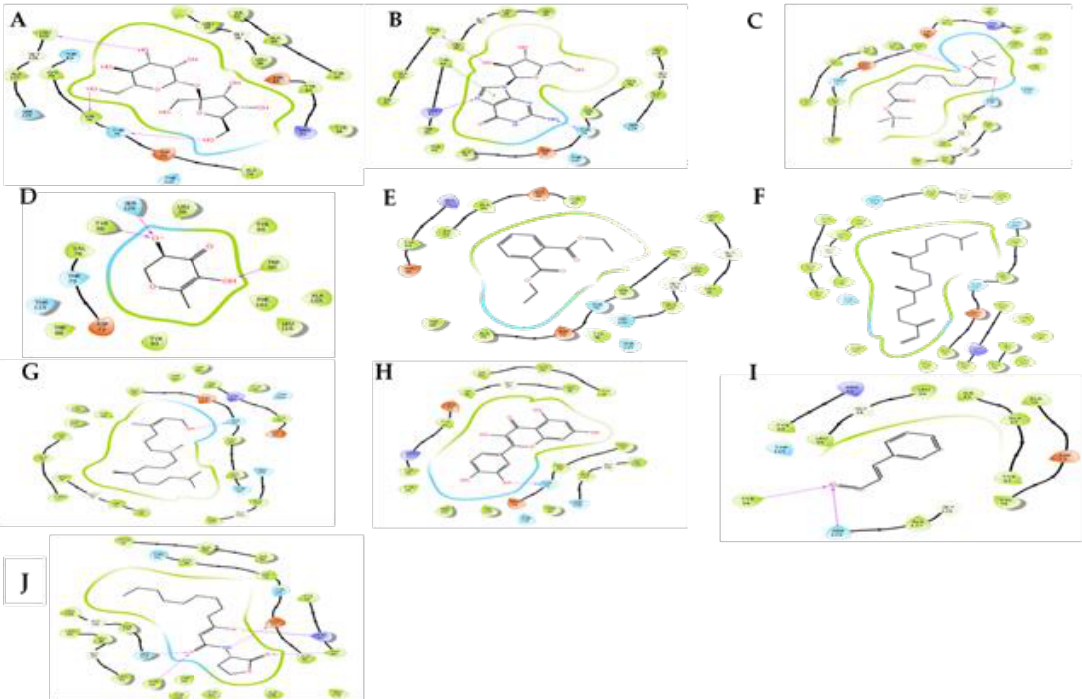
Figure 3. Interaction network between 2UV0 protein and the studied compounds. The protein residues with a negative charge are shown in red, positive charge in velvet, polar in cyan, and hydrophobic in parrot green. The H-bond interactions are shown as a purple arrow, pi-pi stacking as a green line. ( A ) Sucrose; ( B ) guanosine; ( C ) azelaic acid; ( D ) 2.3-dihydro-3.5-dihydroxy-6-methyl-4H-pyran-4-one; ( E ) 1,2-benzenedicarboxylic acid, diethyl ester; ( F ) neophytadiene; ( G ) phytol; ( H ) quercetin; ( I ) cinnamaldehyde and ( J ) 3-oxo-C12-HSL.